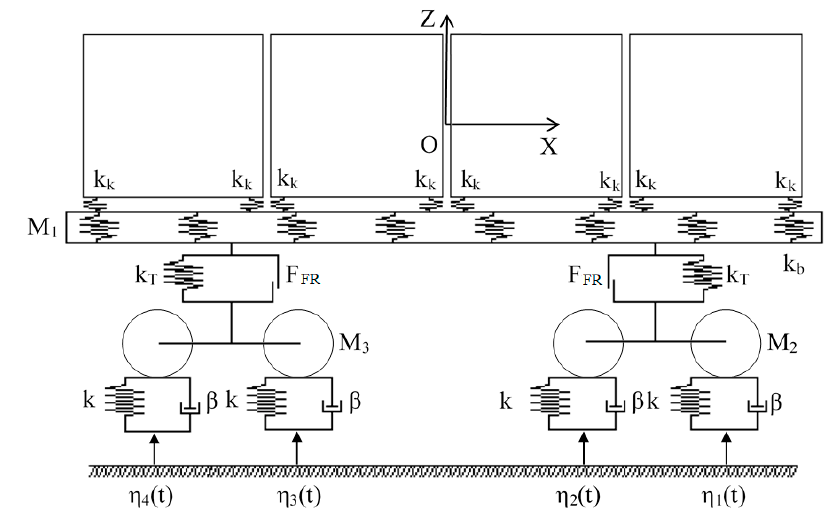
Figure 4. Design diagram of the bearing structure of a flat car loaded with